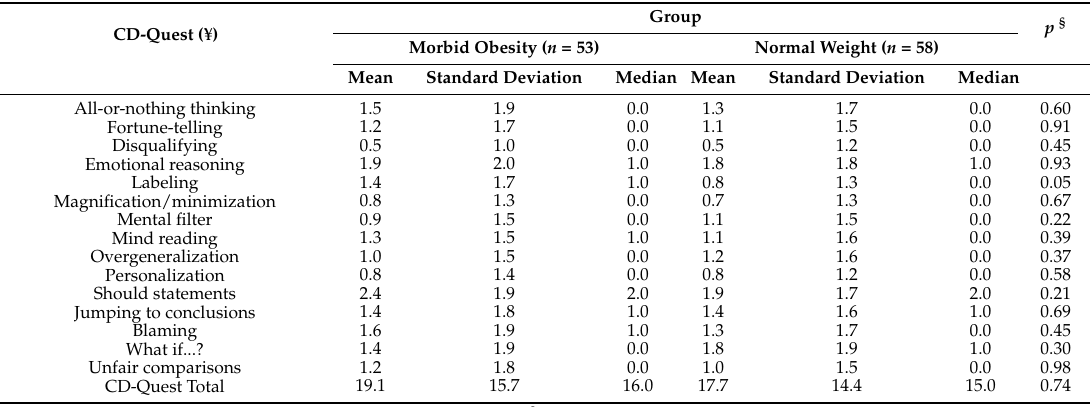
Table 3. Cognitive distortions as assessed by the CD-Quest in participants with morbid obesity versus participants of normal weight.